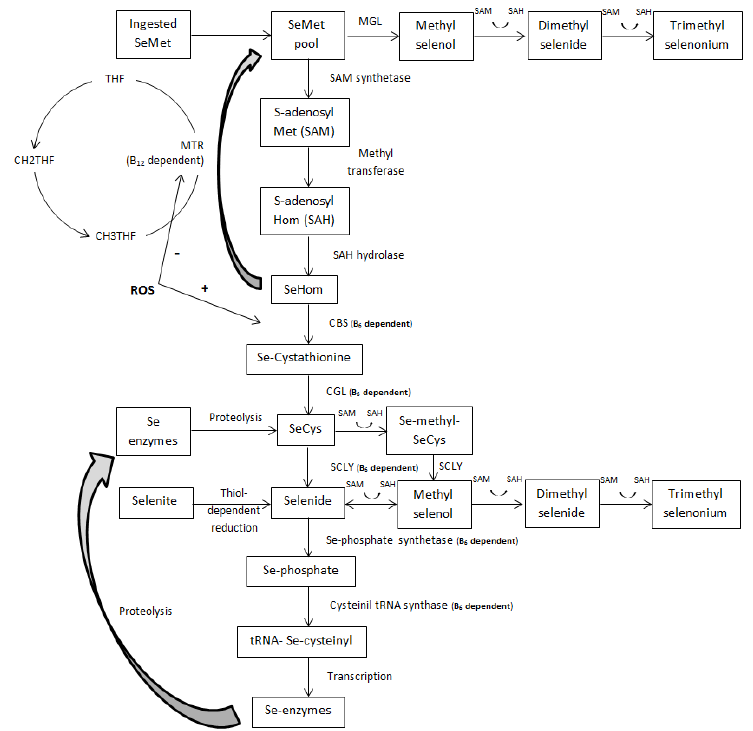
Figure 1. Transmethylation and transsulfuration pathways of selenium (similar for sulfur counterparts) in adults. Selenomethionine (SeMet) is methylated to methyl selenol by methionine γ